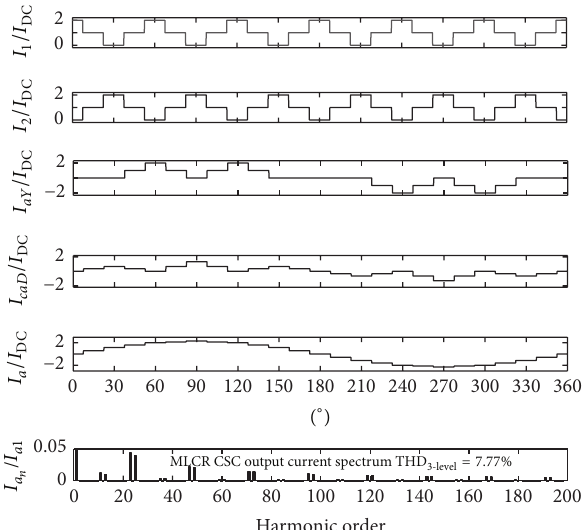
Figure 2: Current waveforms for 3-level thyristor based MLCR CSC with Linear Reinjection.